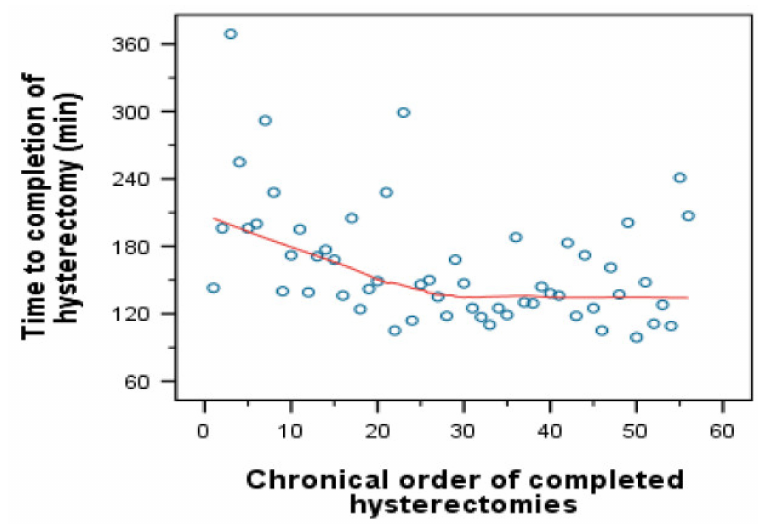
Figure 3. The linear regression for operating time according to Loess.